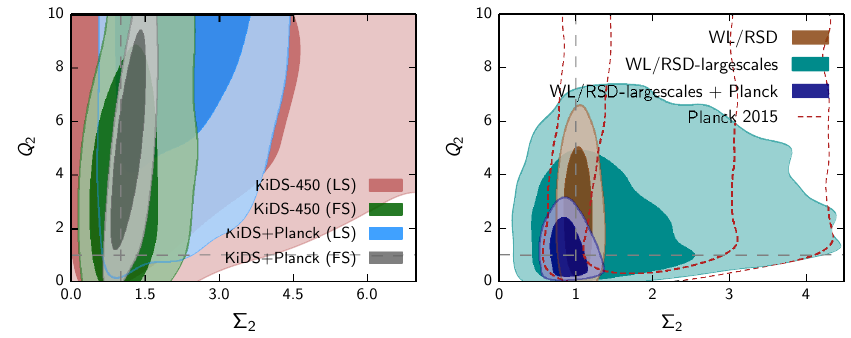
Fig. 7 Left: Marginalized posterior contours (inner 68% CL, outer 95% CL) in the Q 2 − Σ 2 space for KiDS with fiducial angular scales shown in green (labeled by ‘FS’), KiDS keeping only the largest angular scales shown in pink (labeled by ‘LS’), and combined with Planck in grey and blue, respectively. The indices represent the combination of MG bins, such that z < 1 and k > 0 . 05 h Mpc − 1 . The intersection of the dashed lines give the GR prediction (i.e., Q = Σ = 1). Reproduced with permission from Fig. 13 in Joudaki et al. (2017). Right: In addition to the cases described on th left, the constraints include galaxy– galaxylensingcorrelationwithcosmicshearinWLandRSDdataasdescribedinthetext.’Large-scalecuts’ mean that small scales have been excluded because of no adequate modeling for generic MG deviations in the nonlinear regime that can be utilized here. Again, the intersection of the horizontal and vertical lines is the GR prediction (i.e., Q = Σ =